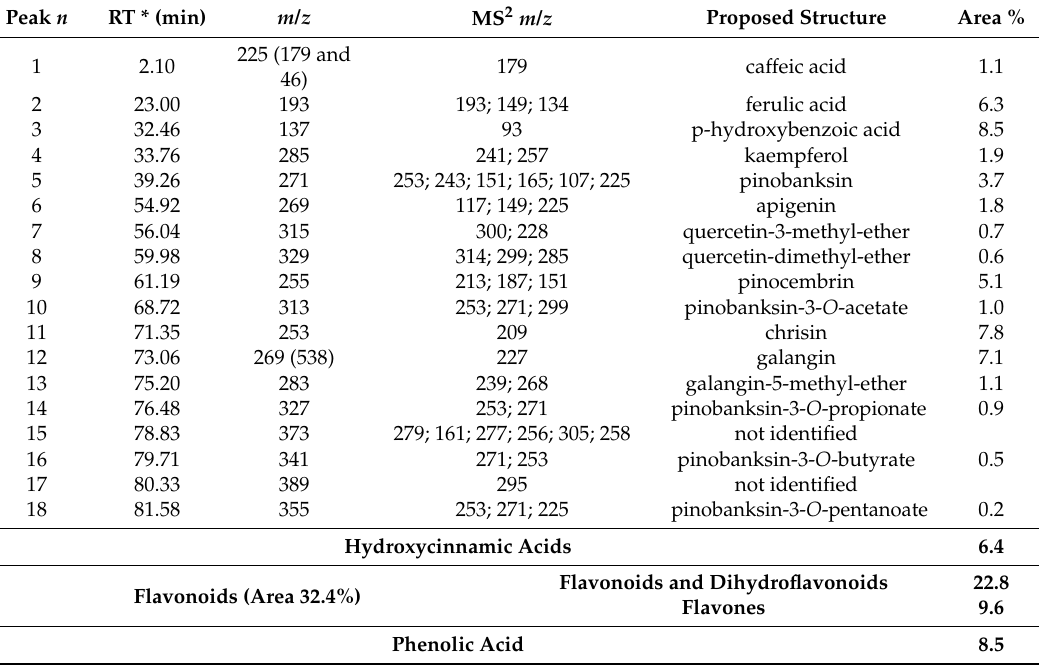
Table 3. Identified compounds in brown propolis by RP-HPLC-PDA-ESI-MSn analyses, registered at 330